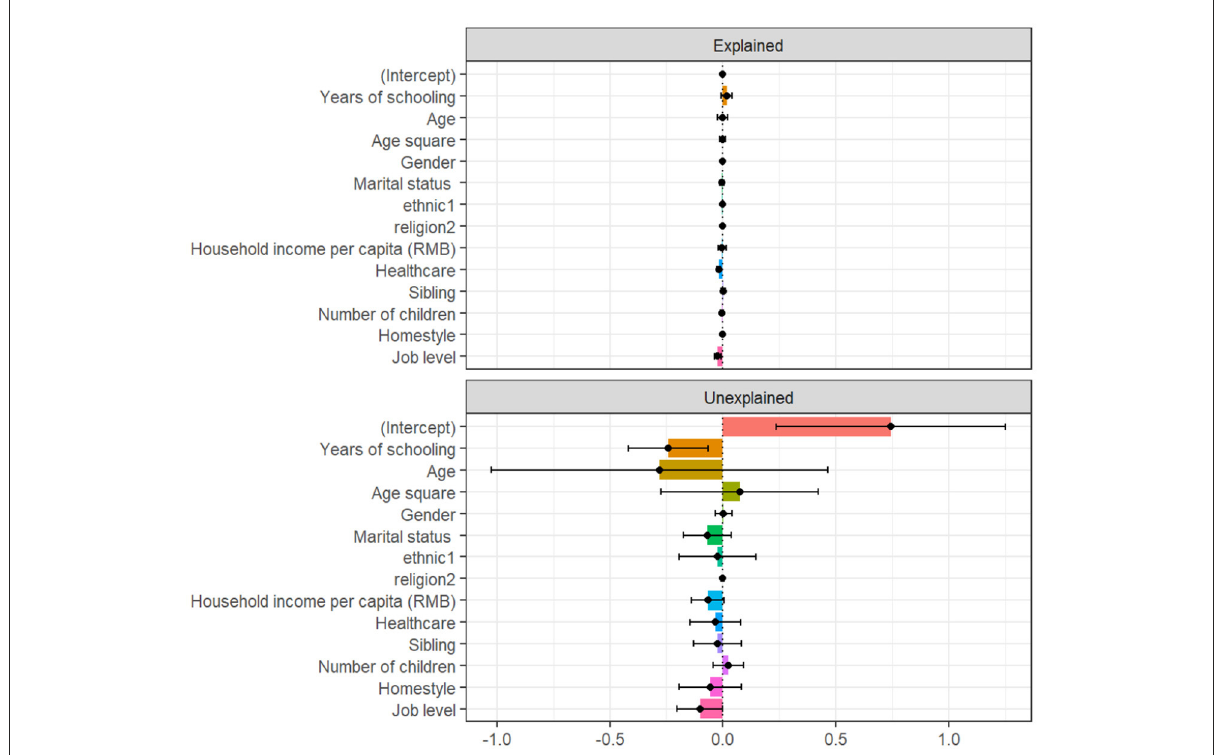
FIGURE1 Oaxaca-Blinder decomposition of years of schooling between urban and rural